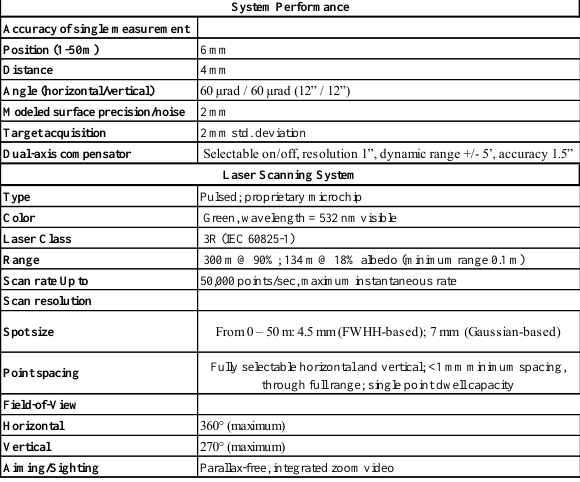
Table 2. Technical Spesifications of Leica Scan Station C-10 (Leica, 2011)